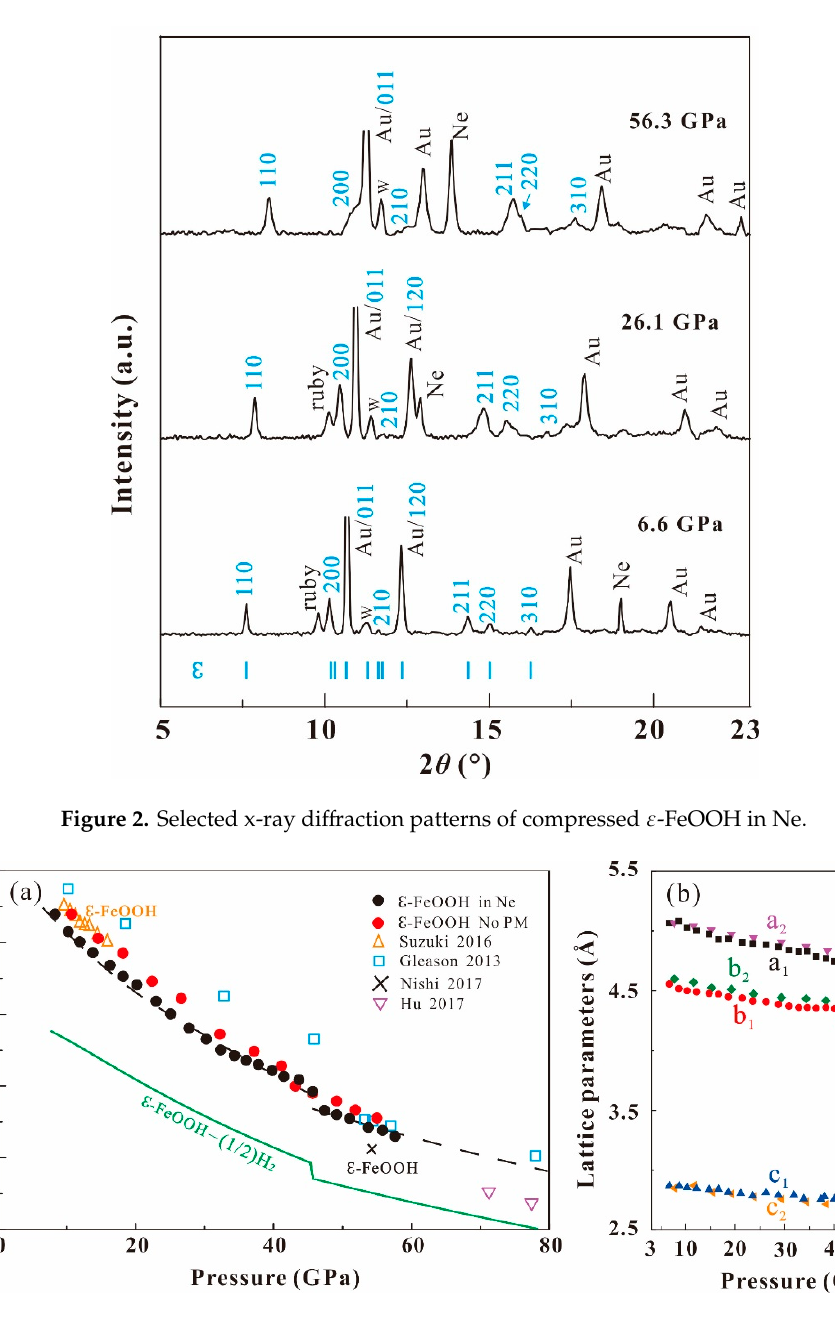
Figure 3. Equation of state for ε -FeOOH. ( a ) Volume versus pressure for ε -FeOOH in this study and literatures. Pressure-volume data for their high-spin or low-spin states were fitted to the third order Birch-Murnaghan equation of states. “X” and reversed triangle symbol were ε -FeOOH obtained by reheating Py-FeO 2 H x out of its stability range. Open spheres were fully hydrogenated ε -FeOOH. Pressure was calibrated by ruby and Au (gold) with up to ± 1 GPa uncertainty. ( b ) The lattice parameters of ε -FeOOH as a function of pressure under different pressure environments. a 1 , b 1 , and c 1 for hydrostatic conditions and a 2 , b 2 , and c 2 for non-hydrostatic conditions. PM, pressure medium.